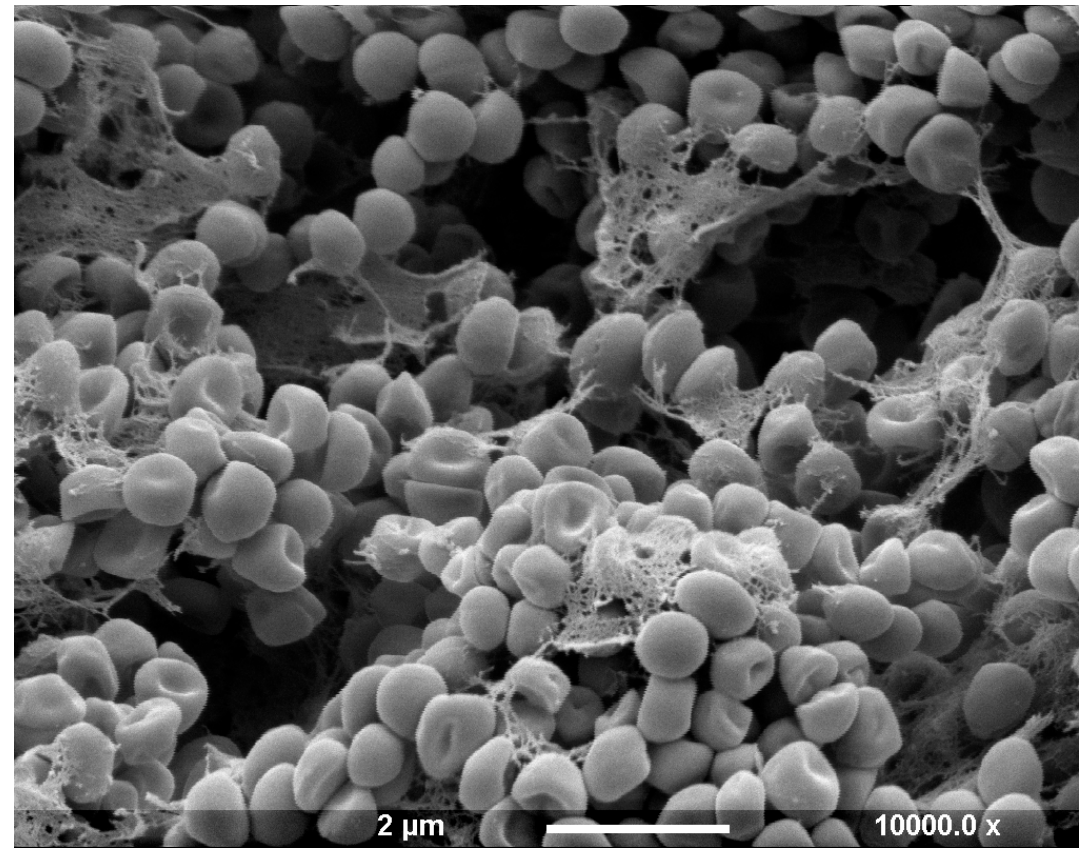
Figure 4. Scanning electron micrograph of a six-day-old Staphylococcus epidermidis biofilm demonstrating bacteria within an extracellular polymeric substance. Scale bar: 2 µm.